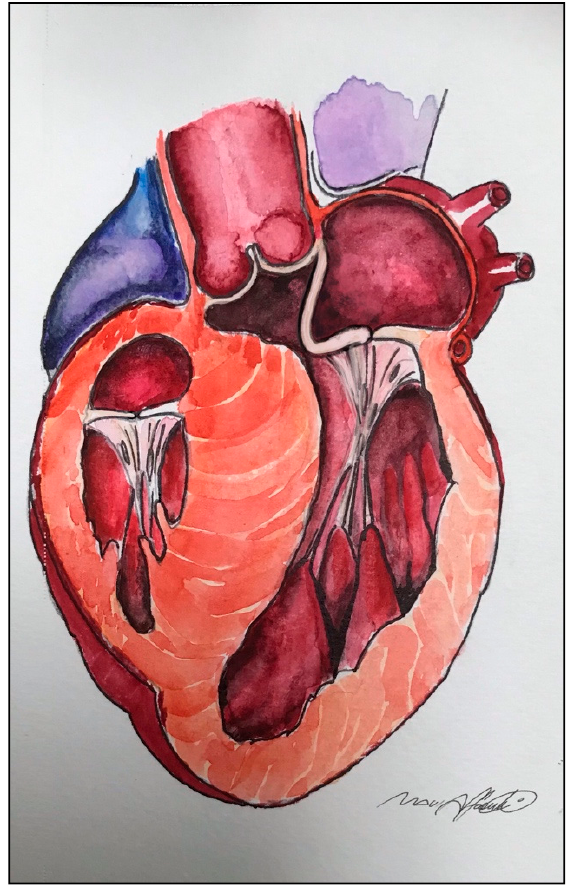
Figure 1. An elongated anterior mitral leaflet contributing to secondary systolic anterior motion (SAM) and left ventricular outflow tract (LVOT) obstruction.